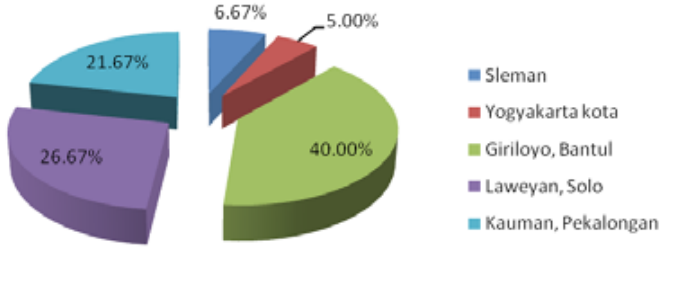
Graph 1: Percentage of Respondent Batik SMEs based on Areas in Field Study batik from the respondent of